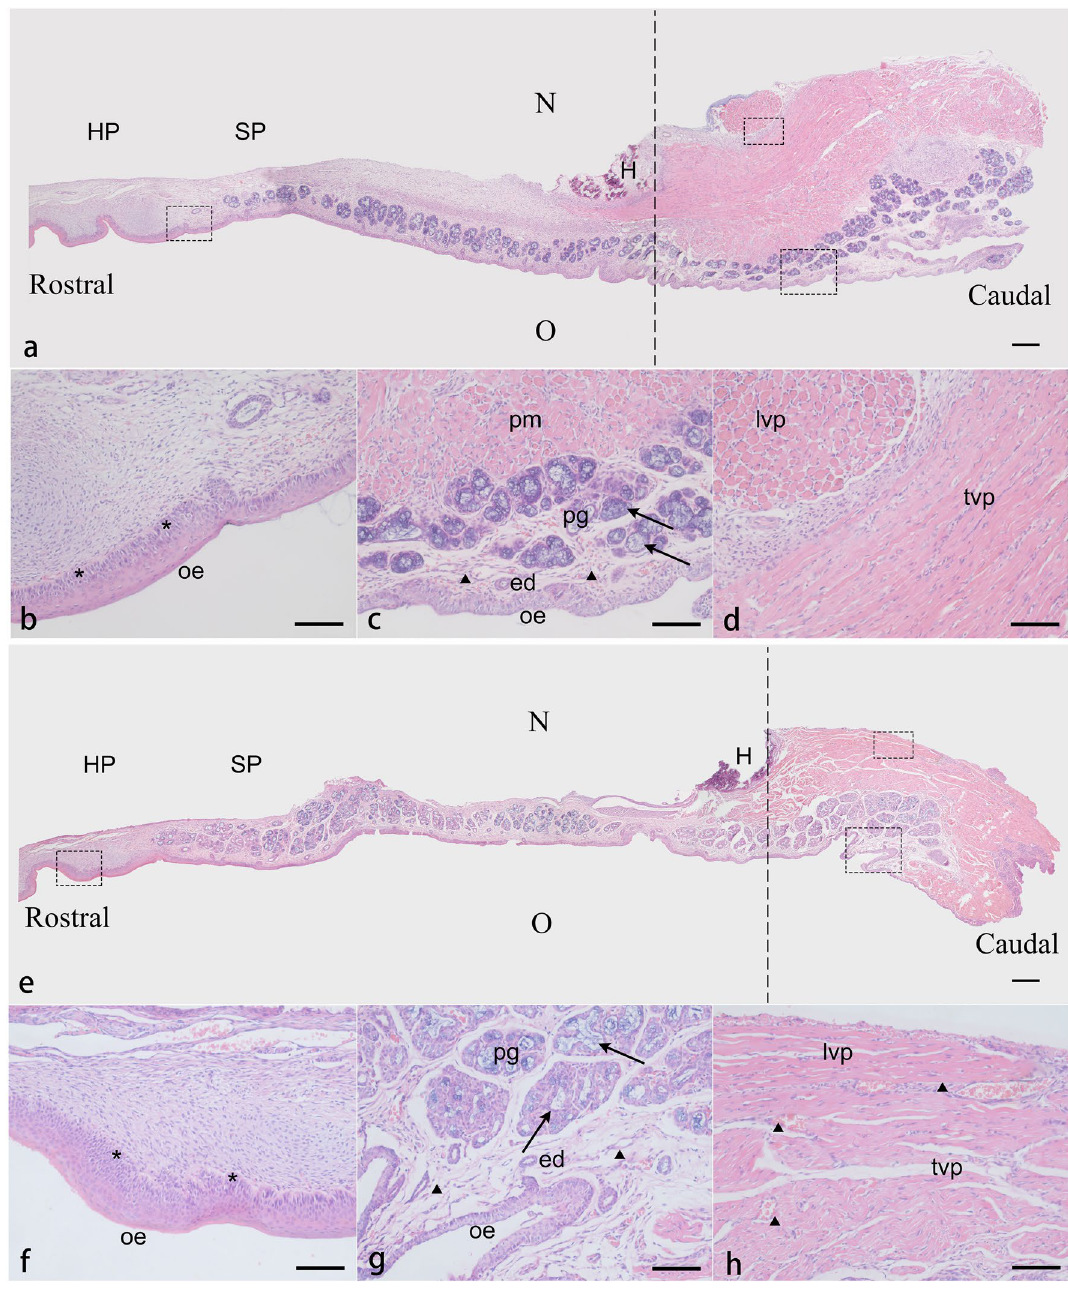
Figure 4. Histology view of the midsagittal sections of the palate in the control ( a–d ) and the cleft ( e–h ). Paraffin sections were cut at the level of the pterygoid hamulus (H) and stained with H&E. The dotted lines indicate the level of the coronal sections. ( a , e ) The cleft shows a reduction in the amount of nasal submucosal connective tissue in the hard palate and the anterior soft palate. Muscle tissues account for about the posterior second of the soft palate in the control, while about the third of the soft palate in the cleft. ( b , f ) The asterisk represents in the cleft the disordered arrangement and hyperplasia of the stratum basale cells in adjacent submucosa. ( c , g ) Arrows in the control show that the New Zealand rabbit palatal glands are mixed glands with serous cells surrounding mucous acini. In the cleft group, the degeneration and abnormal morphology of glandular tissue can be seen, and mucous acini are more common. Between a thin stratified squamous epithelium and palatal glands is an underlying loose connective which is thicker and looser in the cleft (the triangle). ( d , h ) The triangle in the cleft also shows the disordered muscle bundle arrangement and hyperplasia of connective tissue and blood vessels between muscle tissue. HP hard palate, SP soft palate, N nasal cavity, O oral cavity, H pterygoid hamulus, oe oral epithelium, pm palatal muscle, pg palatal gland, ed excretory duct, lvp levator veli palatini muscle, tvp tensor veli palatini muscle. Scale bars: a , e = 200 µm; b – d , f–h = 50